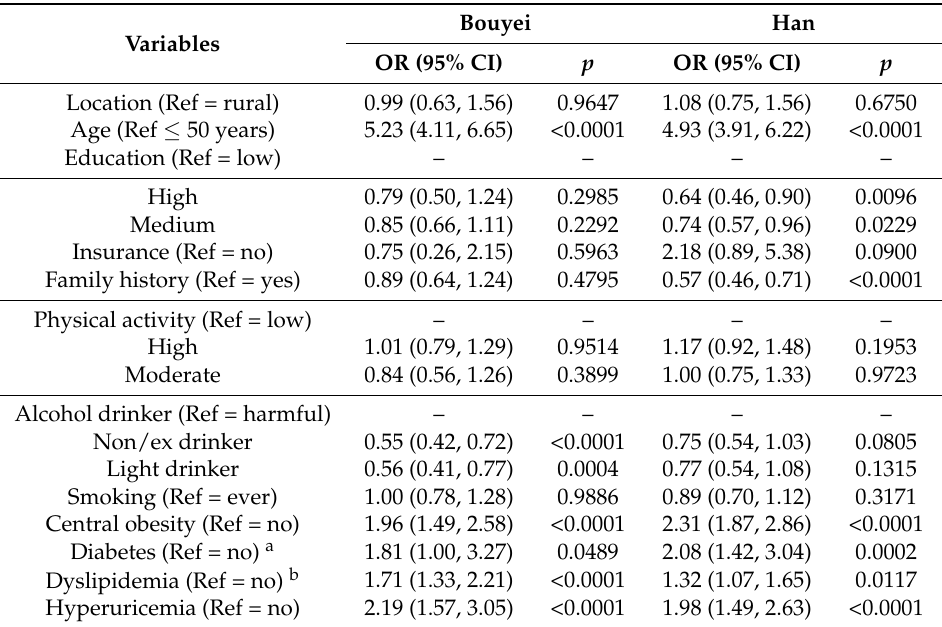
Table 3. Results of Multilevel Logistic Models for Hypertension in Bouyei and